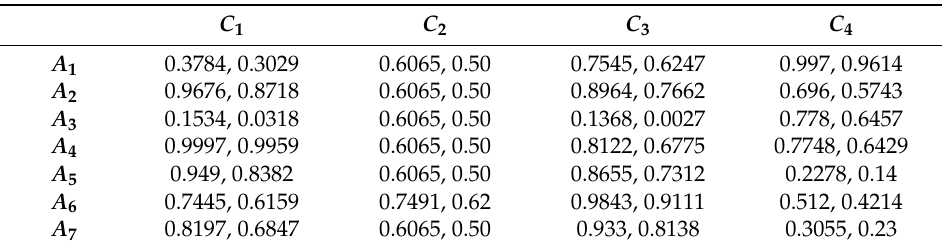
Table 11. Hesitant fuzzy decision